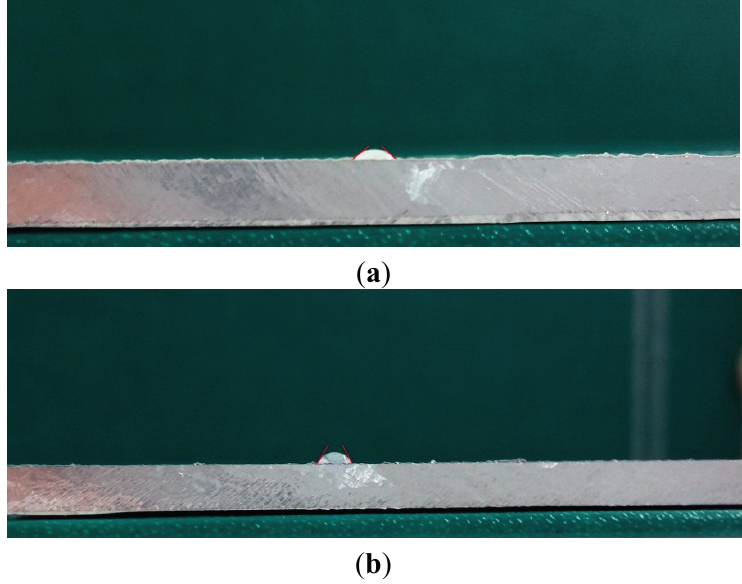
Figure 8. Contact angle of water drops over unfilled water epoxy resin ( a ) and graphene/epoxy resin ( b